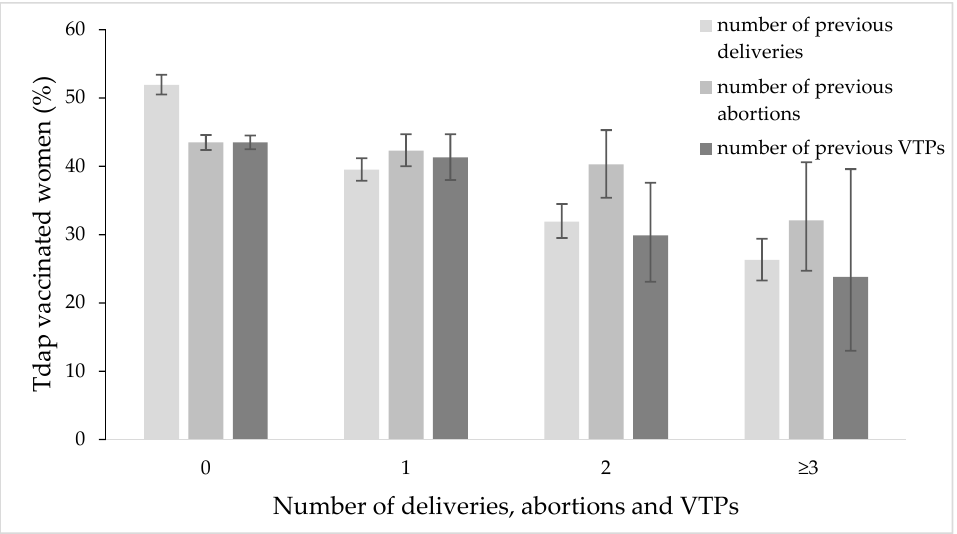
Figure 2. Percentage distribution of Tdap vaccinated women by number of previous deliveries, abortions and VTPs.